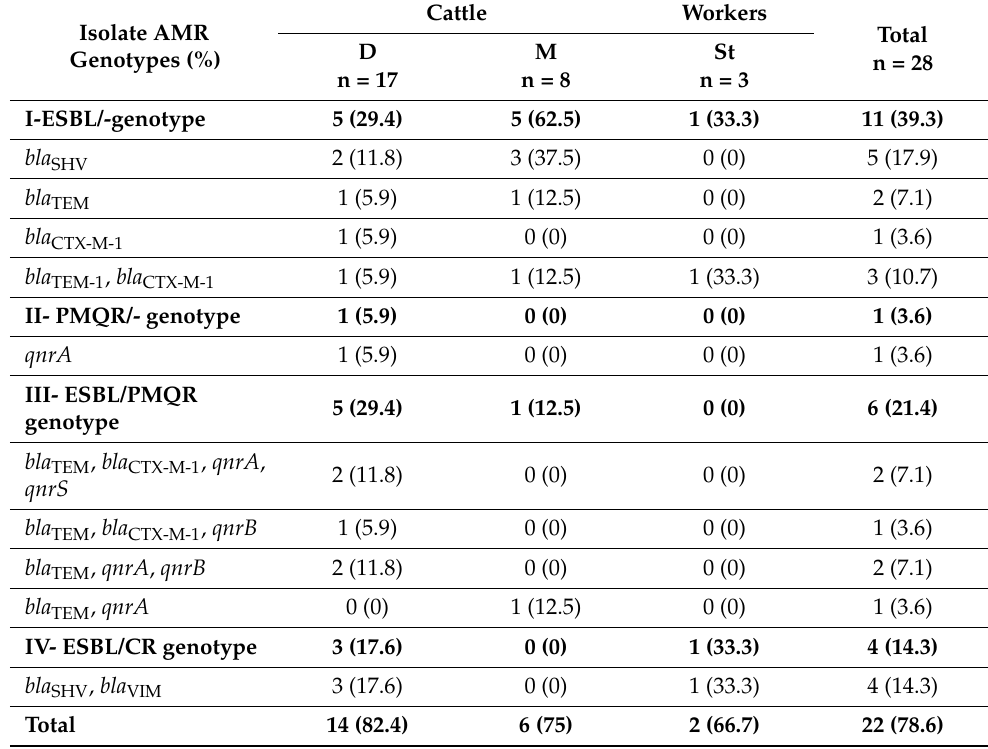
Table 3. Frequency distribution of AMR genotypes per